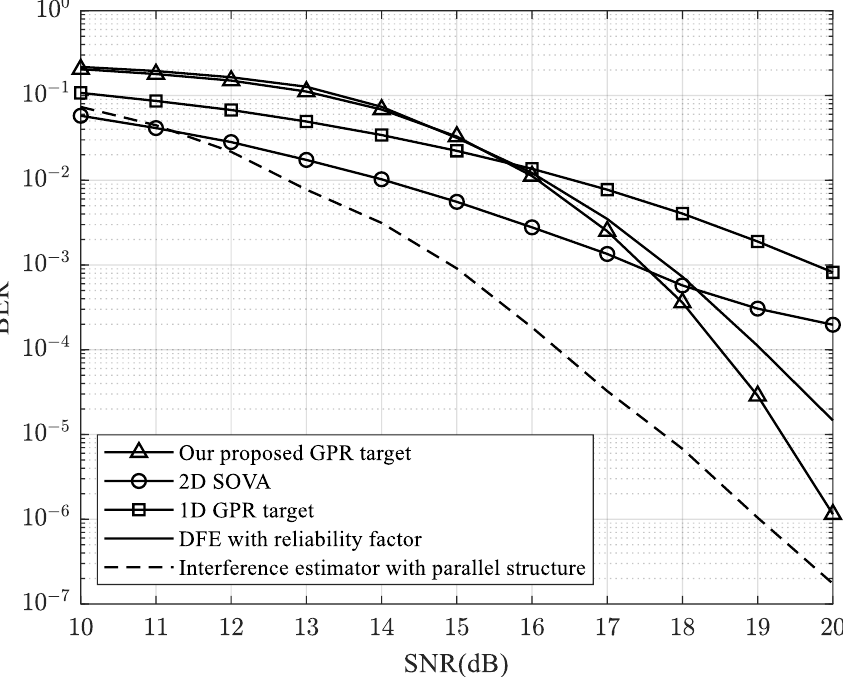
Figure 5. BER of the proposed 2D GPR target at 1.8 blur and 0% misalignment. In Figures 5 and 6, the 1D GPR target model in [16] achieves similar BER performance at 0% and 10% misalignment, while the BER performance of the 2D SOVA model in [13] is significantly degraded at 10% misalignment. However, the proposed model performs almost the same, with 10% misalignment. These results show that the 2D GPR target can estimate the interference of the channel even if the misalignment effect appears. The 1D GPR target model in [13] used the partial response (PR) target, which has the fixed parameter of the target. Thus, when the misalignment appears, it cannot estimate the interference appropriately compared to the 2D GPR target. In addition, the proposed model is also compared to the DFE with reliability factor in [23], and the interference estimator with parallel structure in [22]. The interference estimator with parallel structure scheme achieves better BER performance compared to the proposed model because it is designed with the SOVA algorithm, which requires more complexity, instead of the simple VA used in the proposed model. Therefore, the proposed model can give a margin to the system designer for selecting a simple detection architecture. (Section 4.2 compares the complexity of various detection